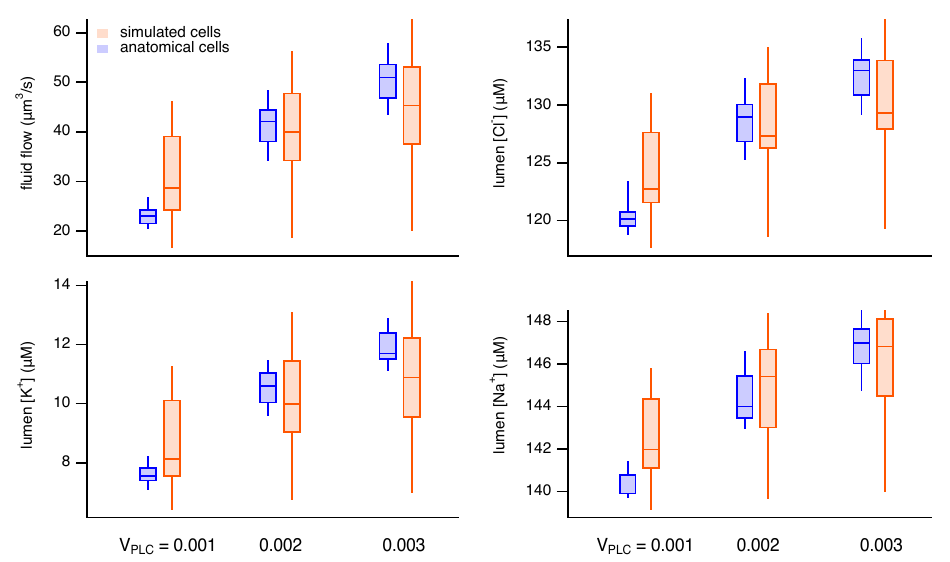
Figure 10. Steady-state fluid flow and lumenal ionic concentrations in simulated and anatomical cells in response to three stimulation levels. The horizontal line within each box shows the median of the relevant group, the vertical lines (the “whiskers”) extend to the maximum and minimum point in each group, while the box extends from the first quartile to the third